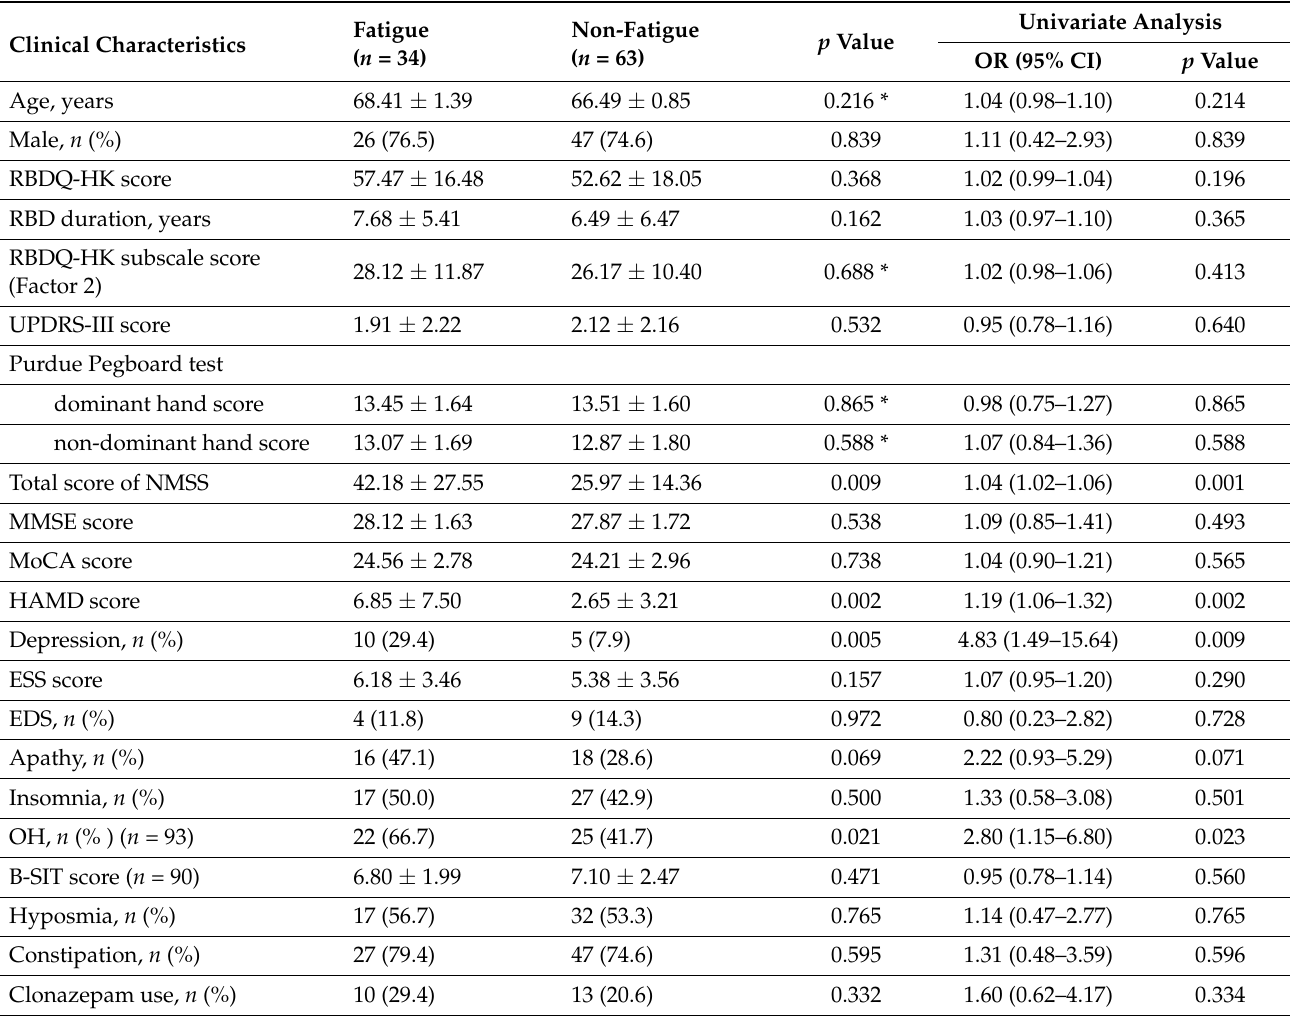
Table 1. Baseline clinicodemographic characteristics and univariate analyses of fatigue in patients with iRBD.